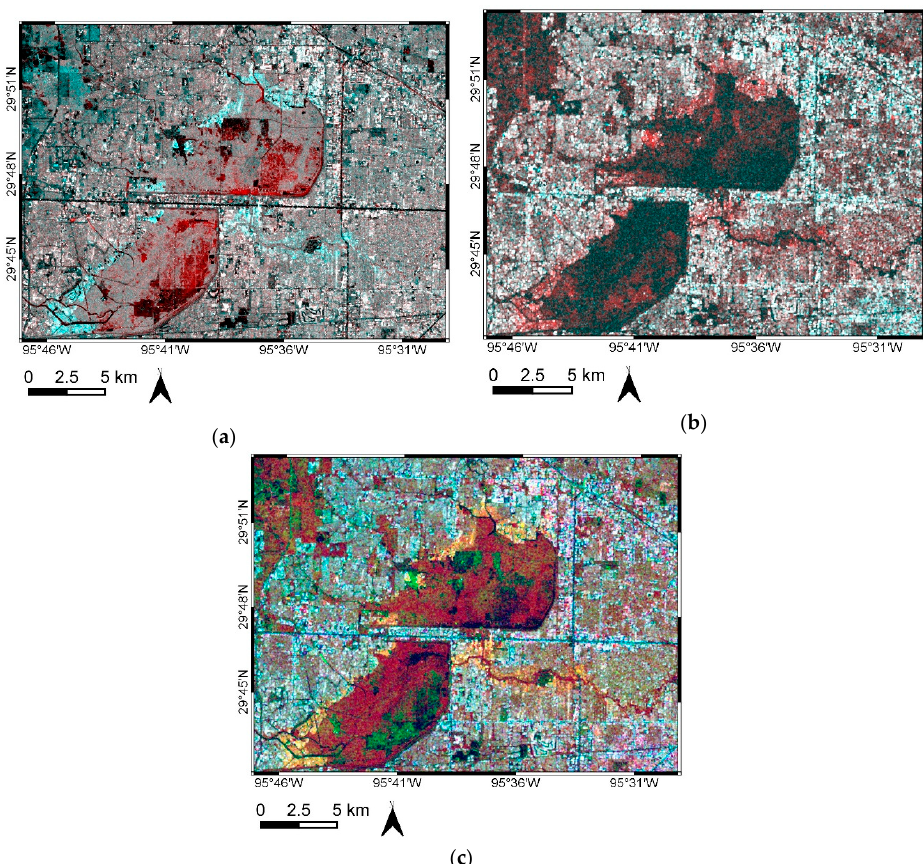
Figure 2. RGB color composites of the Houston case study: ( a ) Intensity RGB composite, R = σ ° of August 24, 2017, G = B = σ ° of August 30, 2017; ( b ) Coherence RGB composite, R = γ of August 18– August 24, 2017, G = B = γ of August 24–August 30, 2017; ( c ) Intensity and coherence RGB composite, R = σ ° of August 30, 2017, G = γ of August 18–August 24, 2017, B = γ of August 24–August 30, 2017. Table 5. Quantitative evaluation of the Houston flood case (FPR: false-positive rate, OA: overall accuracy).